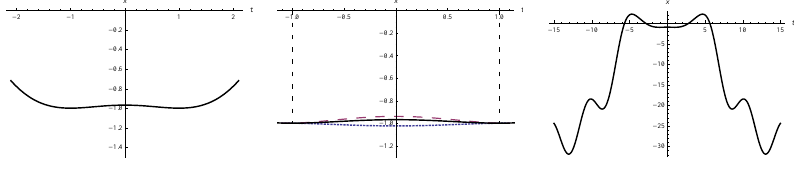
Figure 3. Solution of the problem